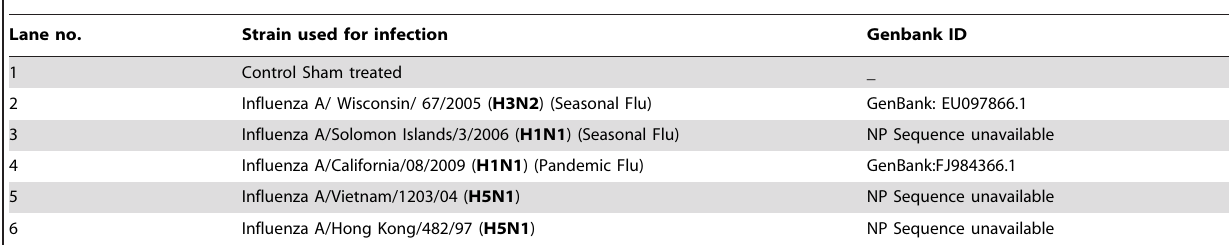
Table 1. Influenza A virus strains used in the study.